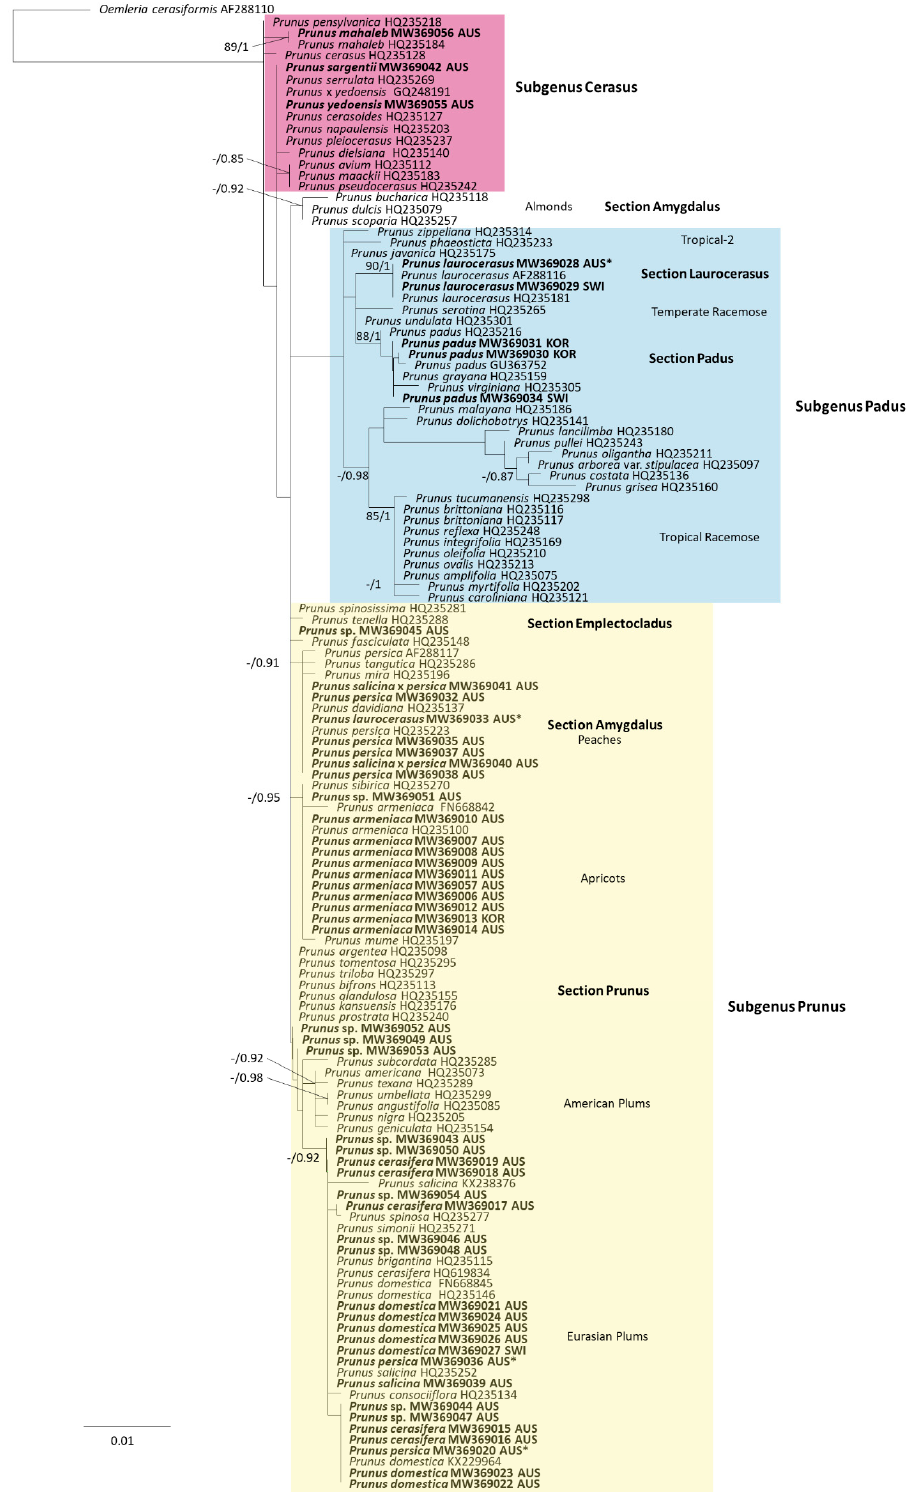
Figure 3. Maximum likelihood phylogenetic analysis of matK chloroplast gene sequences for host Prunus species. Branch support values for maximum likelihood (bootstrap (BS)) and Bayesian inference (BI) analyses are shown when >70% and 0.85, respectively. Colours represent Prunus subgenera; Cerasus is red, Padus is purple and Prunus is green. Sequences generated from this study are in bold and sequence names as deposited in reference collections. * Indicates a host that was originally misidentified (under original